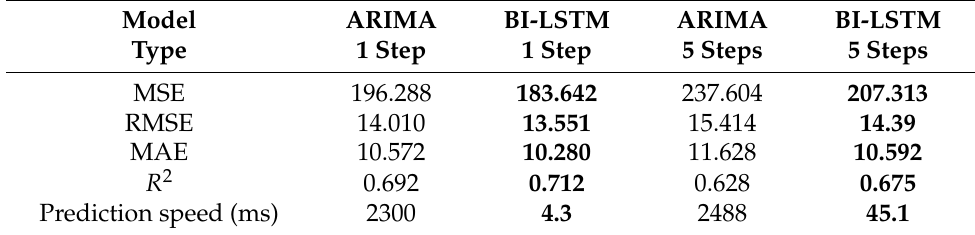
Table 4. Experiment result on NASA